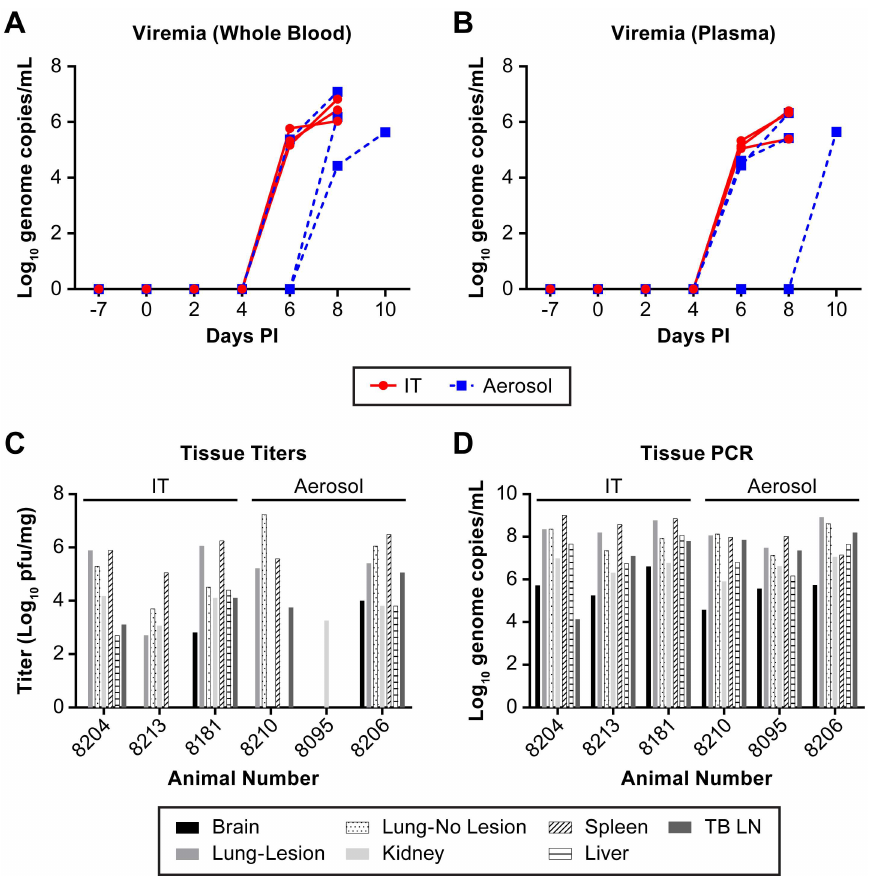
Fig 3. Distribution of viral RNA in blood and virus and viral RNA in tissues at necropsy. The presence of viral genomicRNA was determined by RT-PCR analysisin wholeblood (A) and in plasma (B). The presenceof virus in tissues was determinedby plaqueassay (C) and PCR for genomicRNA (D). In panels A and B, IT inoculatedanimalsare indicatedby ( ● ) and aerosol inoculated animals by ( ■ ). Individual animal identifiersare indicatedin panels C and D. These data demonstrate rapid amplification of virus in the blood and the broad distribution of NiV in AGM at necropsy.